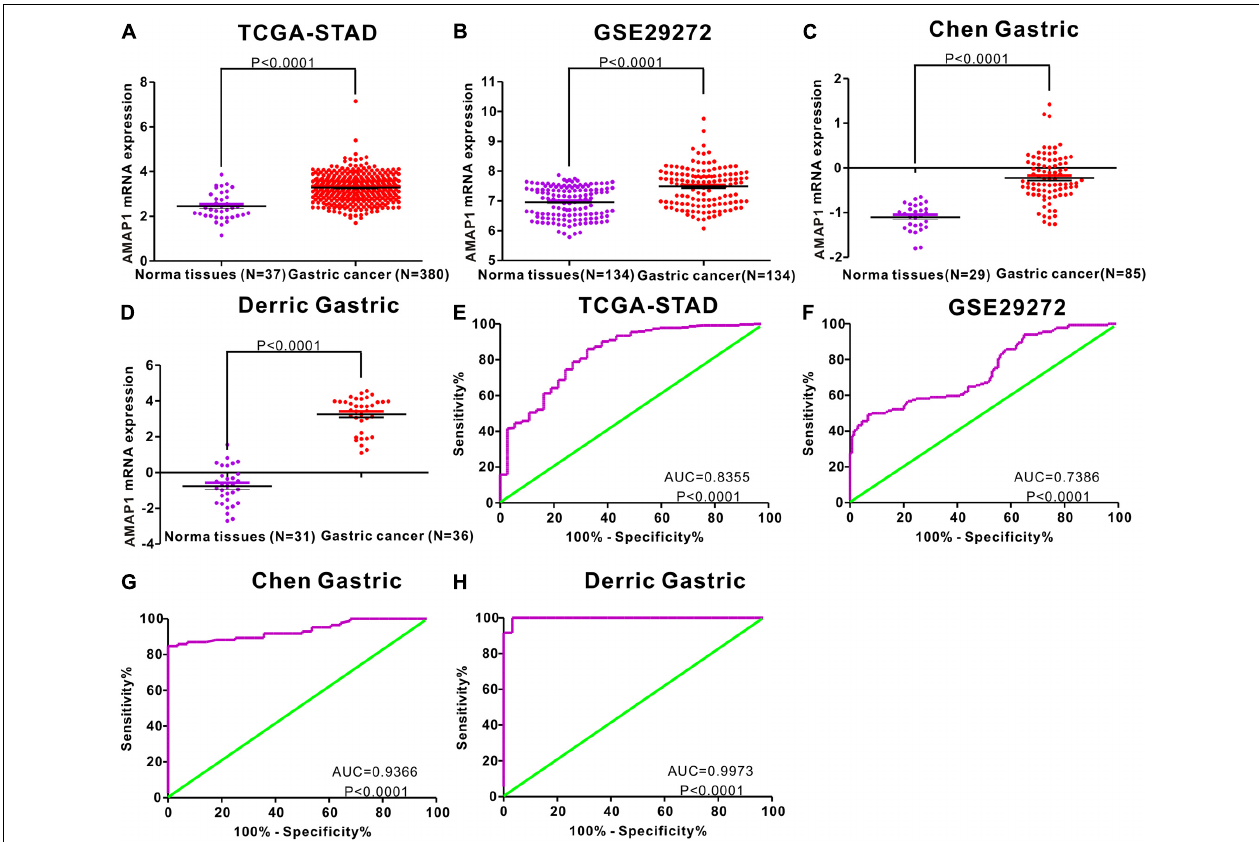
FIGURE 2 | The expression and diagnostic significance of AMAP1mRNA in gastric cancer. Levels of AMAP1mRNA are statistically higher in gastric tissues than that in normal stomach tissues in TCGA-STAD (A) , GSE29272 (B) , Chen Gastric (C) , and Derric Gastric (D) datasets. ROC curves of AMAP1mRNA for the identification of gastric cancer in TCGA-STAD (E) , GSE29272 (F) , Chen Gastric (G) , and Derric Gastric (H)